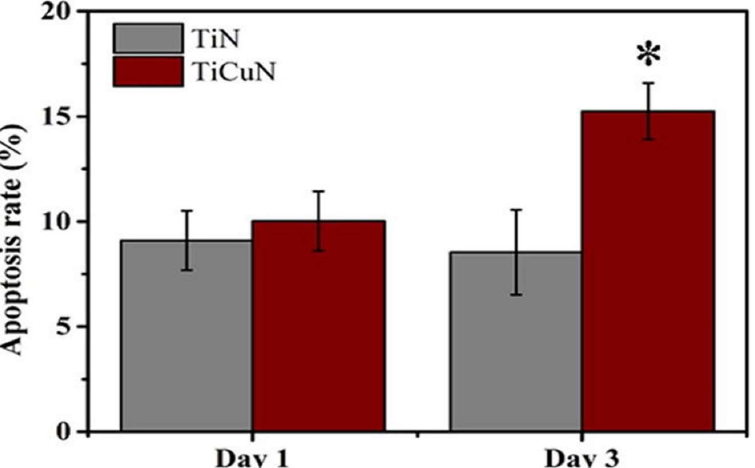
Figure 3. Apoptosis rate of TiN and TiCuN coatings tested for Day 1 and Day 3. Annexin V-FITC/PI double staining kit was used to evaluate the apoptosis rate of these coatings [200]. TiCuN coating promoted the early cell apoptosis rate more than TiN coating. *: Denotes TiCuN coating performance superior